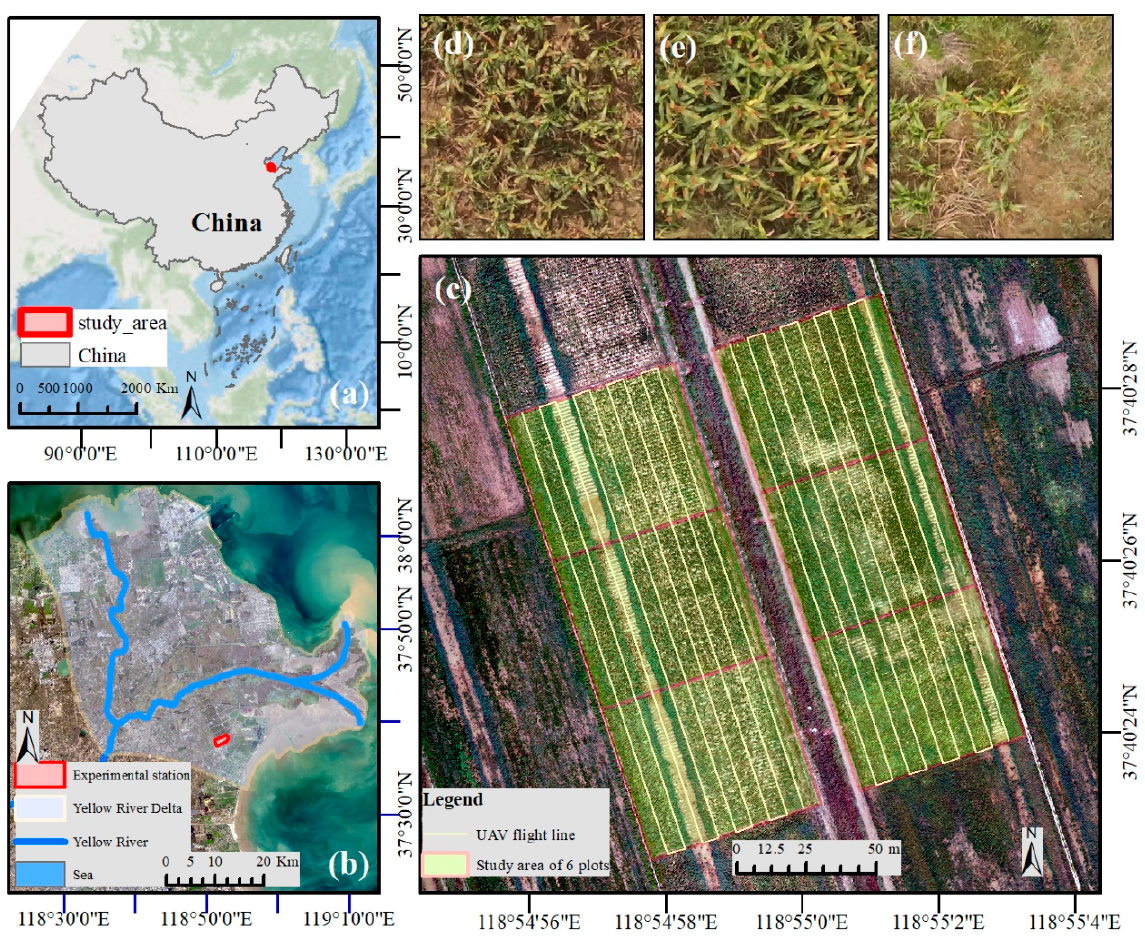
Figure 1. Location of the study area (( a ) shows the location of the study area in China; ( b ) is the location of the experimental station in the Yellow River Delta; ( c ) is the test plots for this study, and ( d – f ) are the examples of UAV images of sorghum heads at different density conditions).